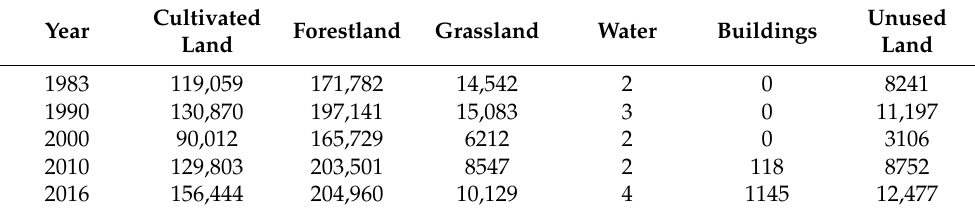
Table 3. The water conservation per unit area for different land types (unit: m 3 /km 2